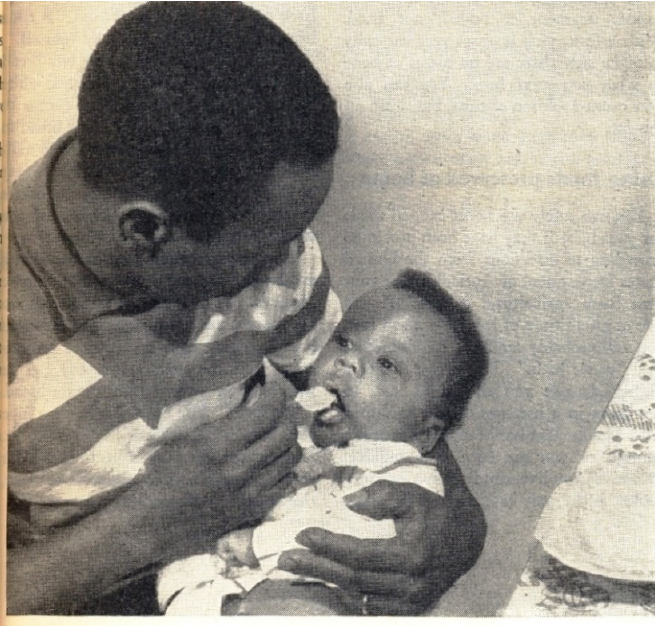
Figure 34. Photo of Black Father Feeding Baby.